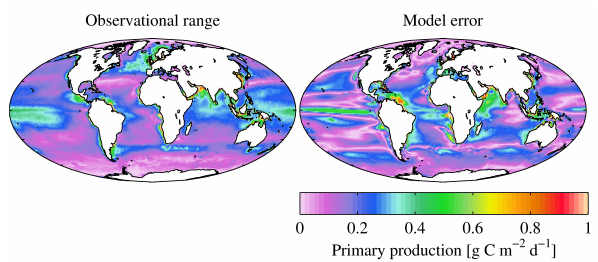
Fig. 48. Comparison of range of annually averaged observa- tional estimates (VGPM, Eppley-VGPM and CbPM) of total oceanic primary production (left) with annually averaged [model – mean(observational estimate)] error (right). Range and error in units of gCm − 2 d − 1